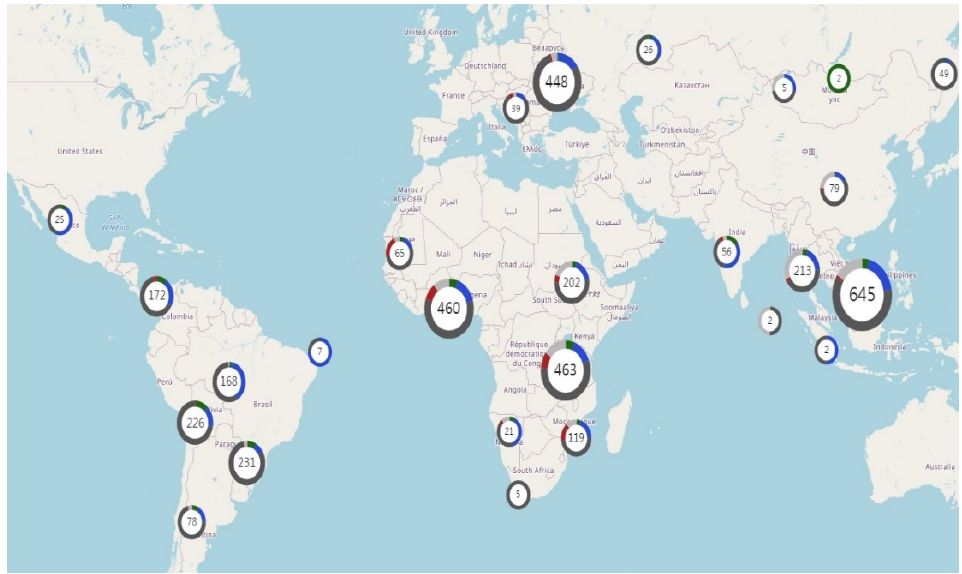
Figure 1. Global land deals [11].